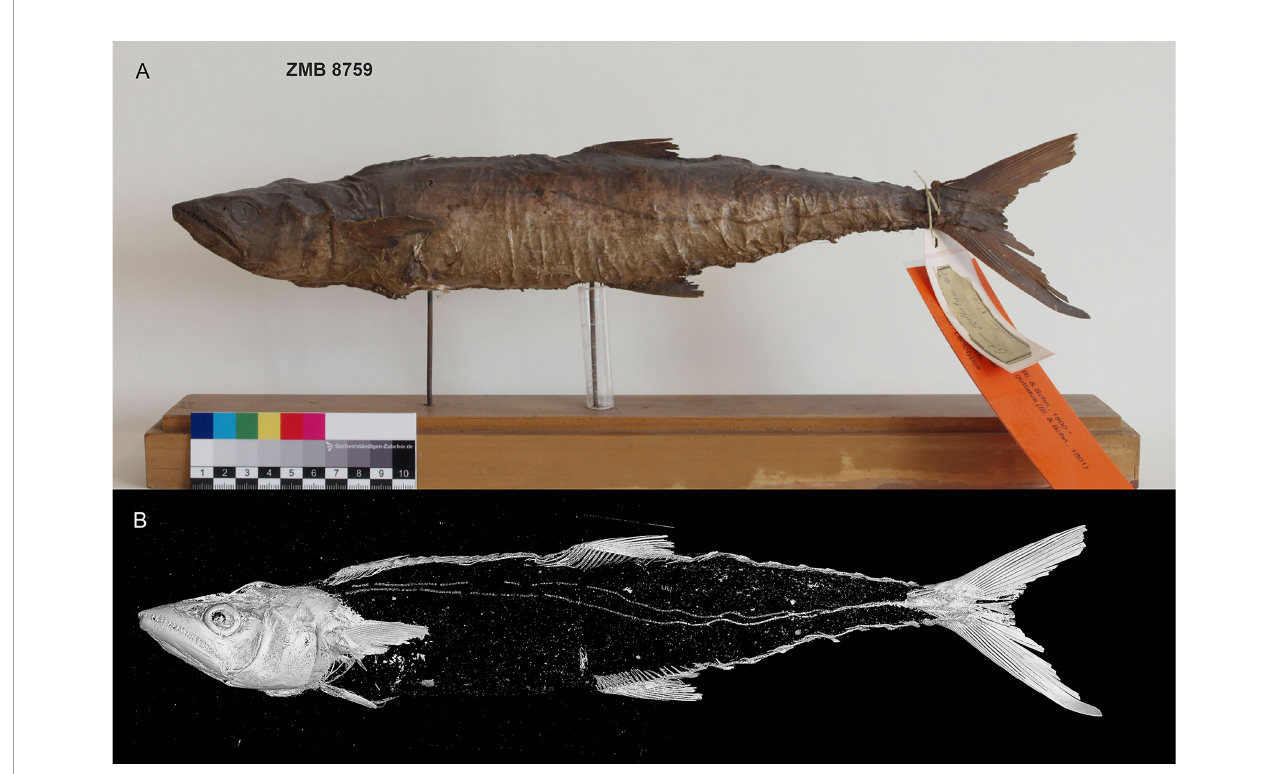
FIGURE 7 | Lectotype of Scomberomorus guttatus (ZMB 8759) collected from Tranquebar, India. (A) Dry, stuffed specimen (373 mm FL and 361 mm SL), and (B) Computed Tomography (CT)